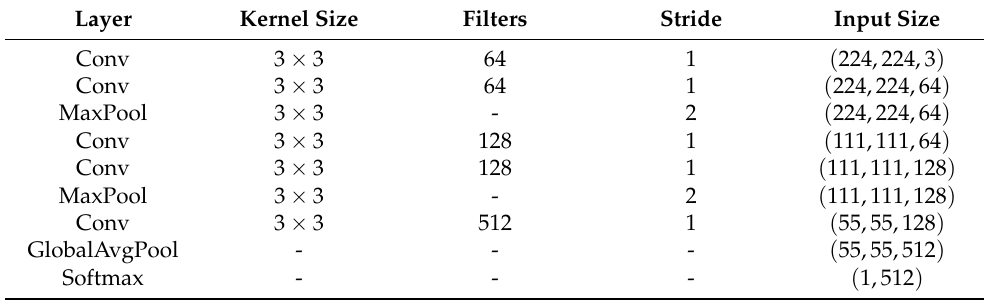
Table 4. Simple neural network model architecture with ≈ 855 K trainable parameters. Layer Kernel Size Filters